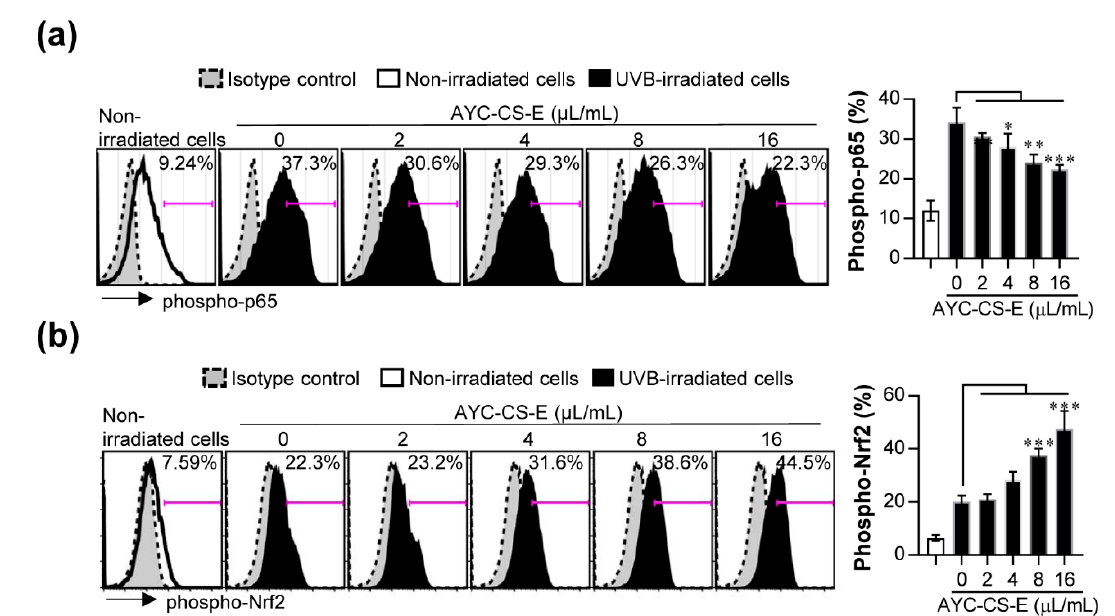
Figure 6. Effect of AYC-CS-E treatment on nuclear factor-kappa B (NF- κ B) signal activation and nuclear factor erythroid 2-related factor 2 (Nrf2) degradation of UVB-irradiated HaCaT cells. ( a ) For phospho-NF- κ B p65 analysis, HaCaT cells were treated with various concentrations (2, 4, 8, or 16 μ L/mL) of AYC-CS-E (30 mg/mL) for 12 h after being exposed to 8 mJ/cm 2 UVB irradiation, and cells were harvested. The harvested cells were fixed/permeabilized and stained with allophycocyanin (APC)-conjugated phospho-NF- κ B p65 (Ser536) antibody for 30 min at 4 °C. ( b ) For phospho-Nrf2 analysis, cells were treated with various concentrations (2, 4, 8, or 16 μ L/mL) of AYC-CS-E (30 mg/mL) for 3 h after being exposed to 8 mJ/cm 2 UVB irradiation, and cells were harvested. The harvested cells were fixed/permeabilized and stained with phospho-Nrf2 (Ser40) antibody for 30 min at 4 °C, and then stained with Alexa Fluor 488-conjugated goat anti-rabbit Immunoglobulin G (IgG) antibody for 30 min at 4 °C. Protein levels of phospho-NF- κ B p65 and phospho-Nrf2 were analyzed by flow cytometry. All bar graphs show the means ± standard deviation (SD) of 3 samples. One representative plot out of three independent experiments is shown. * p < 0.05, ** p < 0.01, or *** p < 0.001.